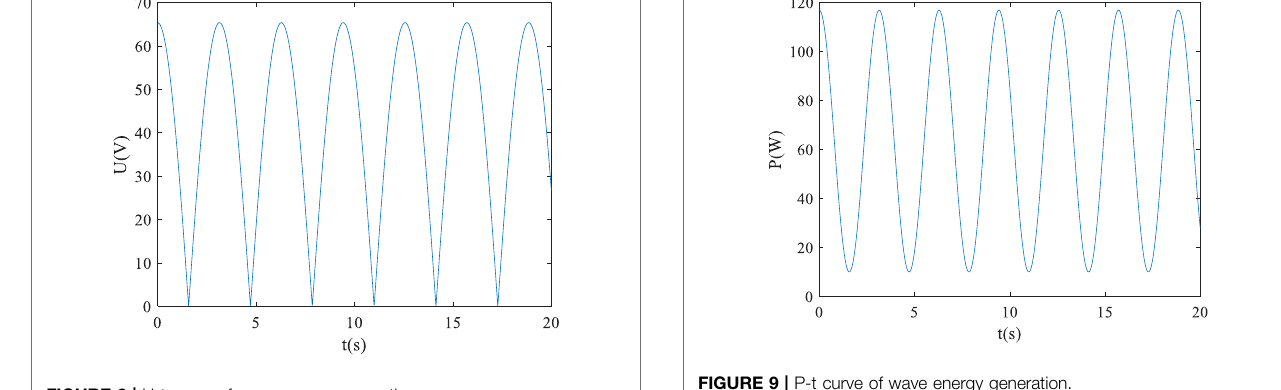
FIGURE 8 | U-t curve of wave energy generation.